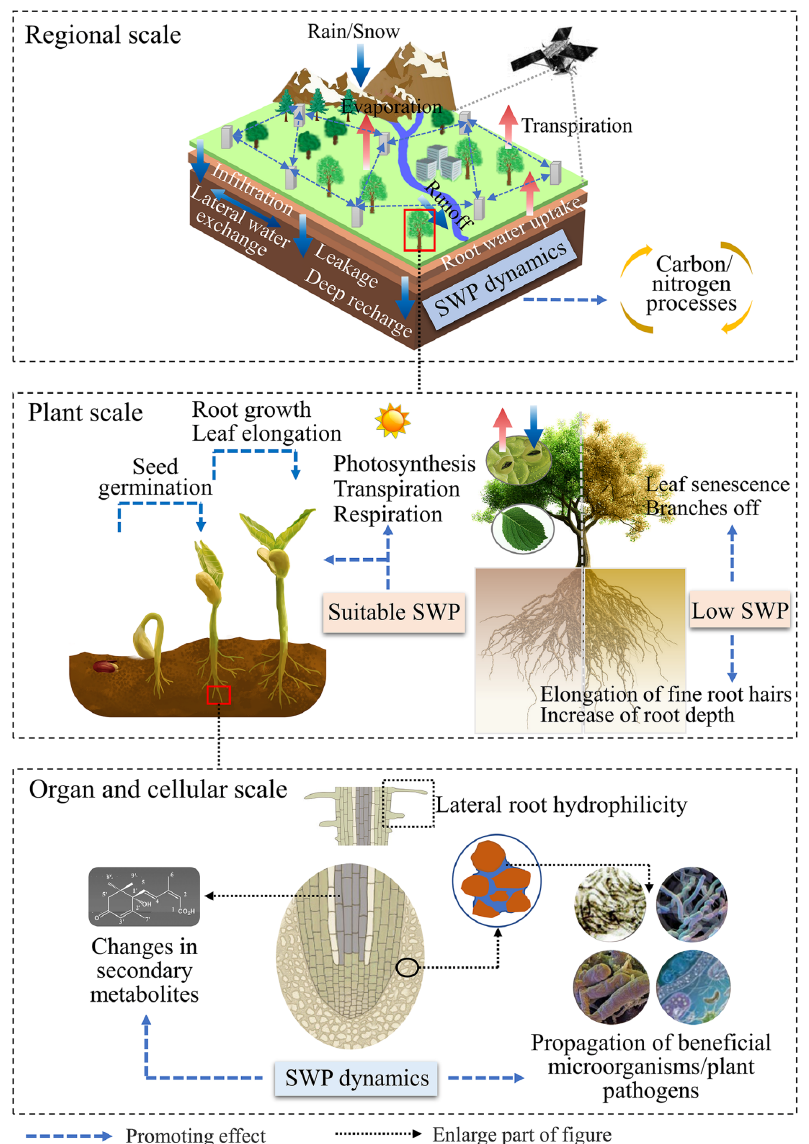
Figure 6. Effects of SWP at the landscape, plant, organ, and cellular scales.